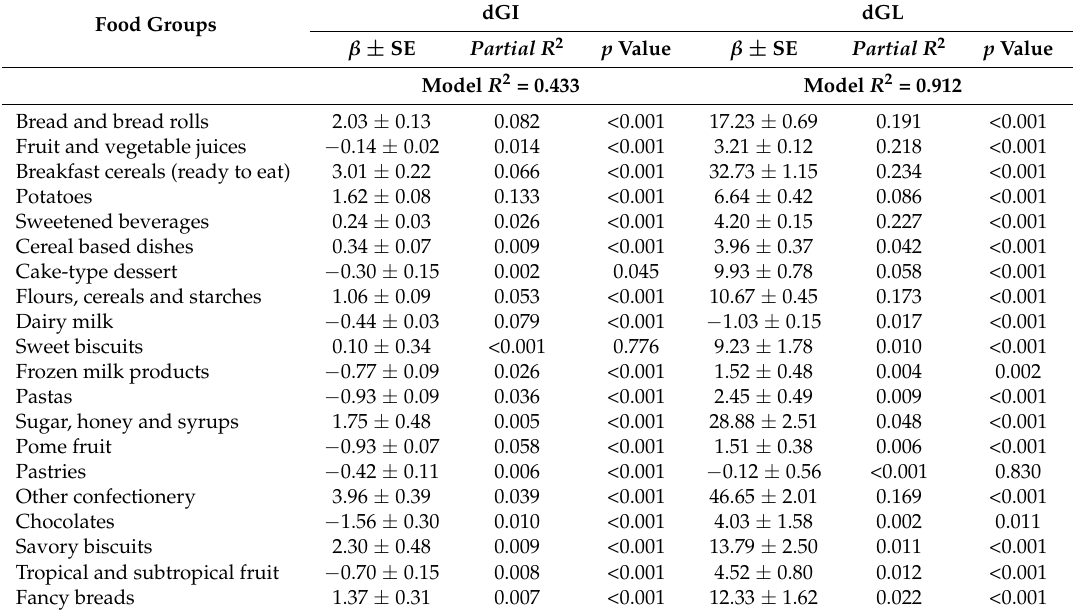
Table A4. The contribution of the top 20 GL food groups to inter-individual variations in dietary glycaemic index (dGI) and glycaemic load (dGL) in 1995NS ( n = 2658, all subjects included).